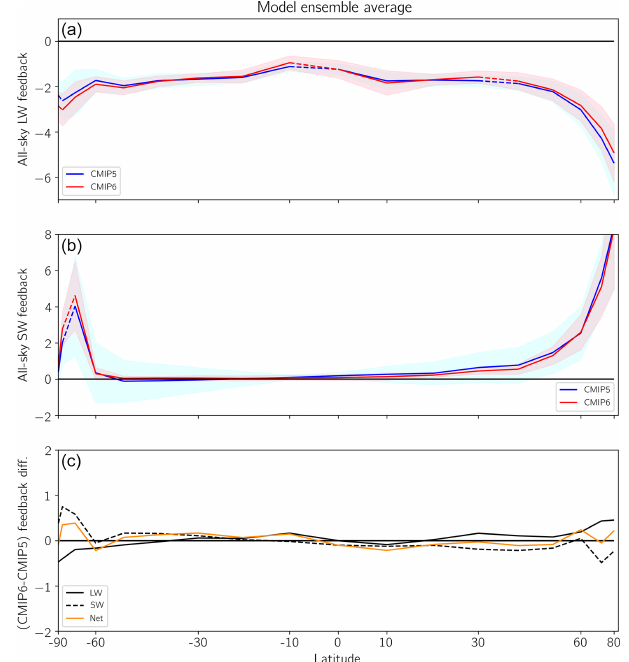
Figure 6. Clear-sky zonal average λ CS,LW (a) and λ CS,SW (b) for the CMIP5 ensemble average (blue) and CMIP6 ensemble (red). Dashed blue and red lines in (a) and (b) indicate regions where difference in mean feedback is statistically significant ( p < 0 . 05). Light blue and red shading represent SD of each ensemble. Panel (c) displays the difference between the CMIP6 and CMIP5 ensemble average SW, LW, and net feedbacks.